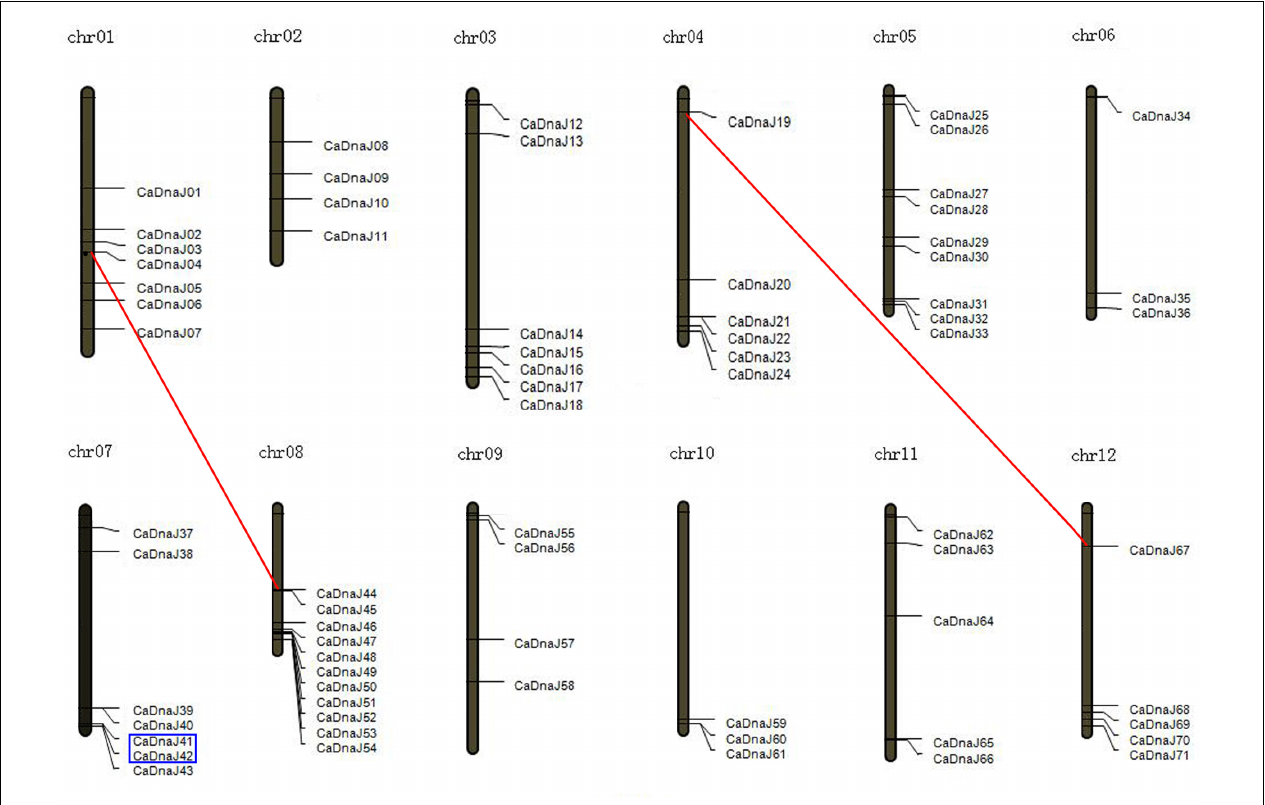
FIGURE 1 | Chromosomal map and duplication event coordinates of paralogous CaDnaJ gene candidates. Segmental duplication and tandem duplication were indicated by red lines and blue boxes,